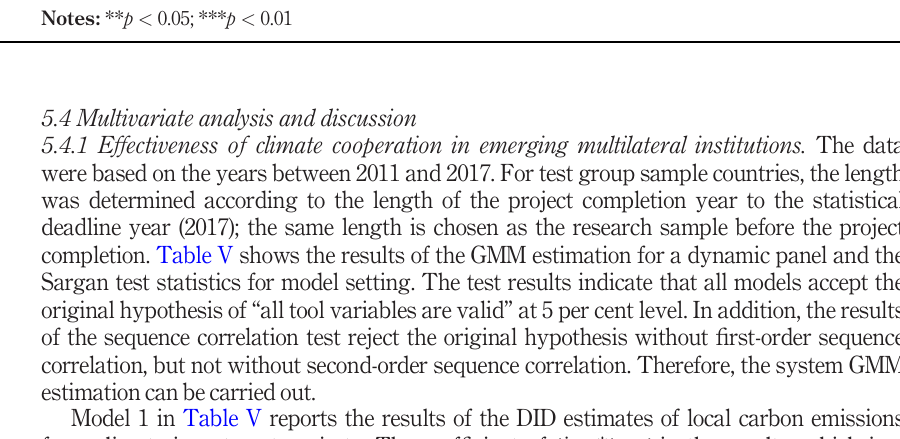
Table IV. Correlation